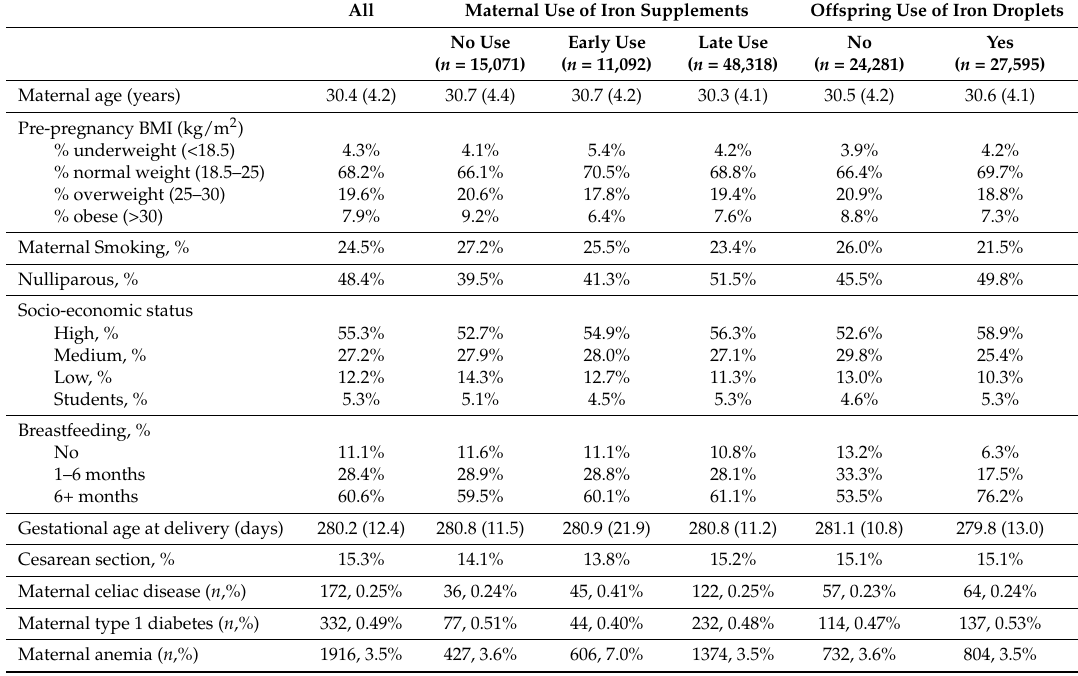
Table 1. Maternal characteristics in relation to maternal use of pure iron supplements and offspring intake of iron droplets during the first 18 months of